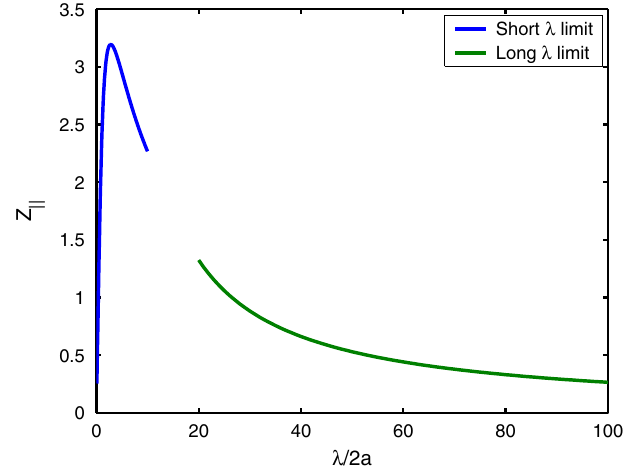
FIG. 4. (a) Schematic drawing of a horizontal beam shape distortion caused by energy modulation. Also, the sketch depicts the x component of the coherent field and one of the beam slices that are used to calculate this field. (b) A schematic drawing of a cylindrical beam slice with its longitudinal and transverse